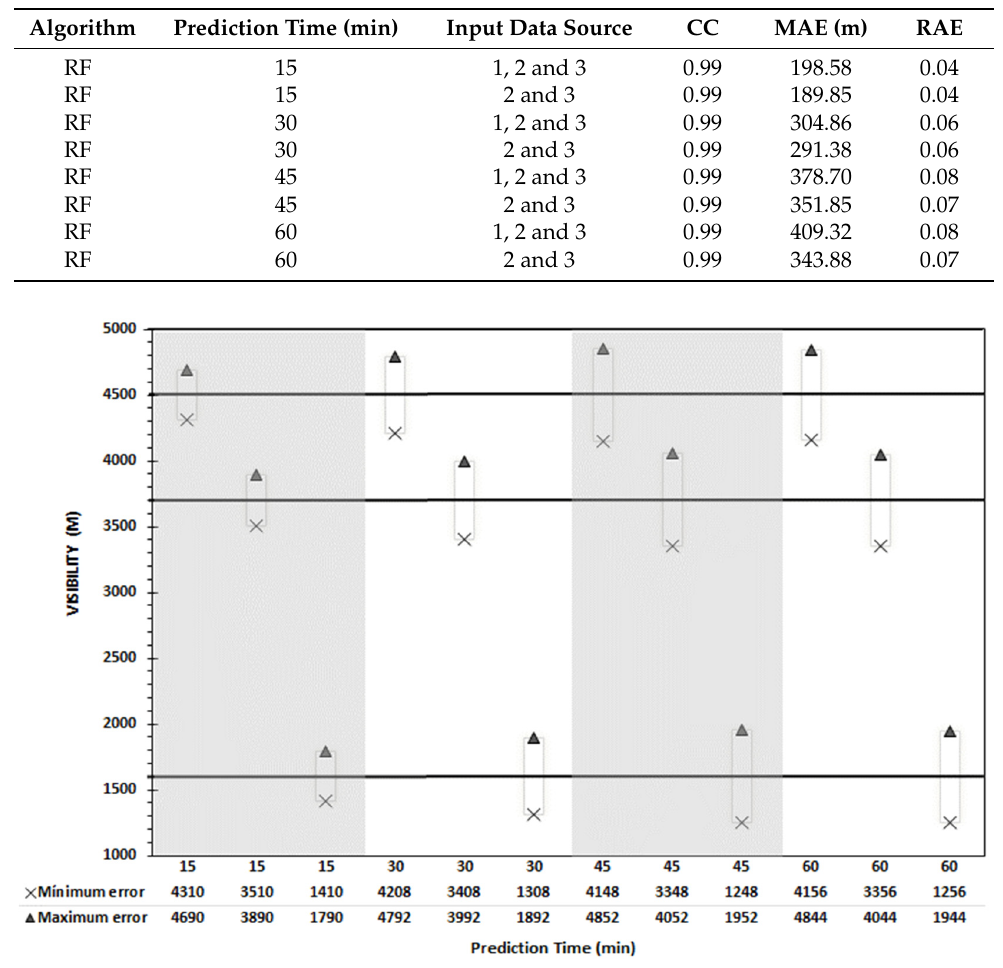
Figure 4. Minimum (cross) and maximum (black triangle) errors for each visibility threshold (± mean absolute error), represented by the horizontal black lines at 4500, 3700, and 1600 m of the best regressive forecasts of 15, 30, 45, 60 min in Table 9. Figure 5 exemplifies the performance of the set of predictions and observations for a low-visibility event that occurred between 5 am and 1 pm on 23 June 2009. Regardless of the forecast time, it is noted that the 15, 30, 45 and 60 min visibility forecasts followed the behavior of the observation (black line in Figure 5) with all correlation coefficients > 0.95 and their mean absolute errors ≤ 321 m. This can be verified through the behavior of the